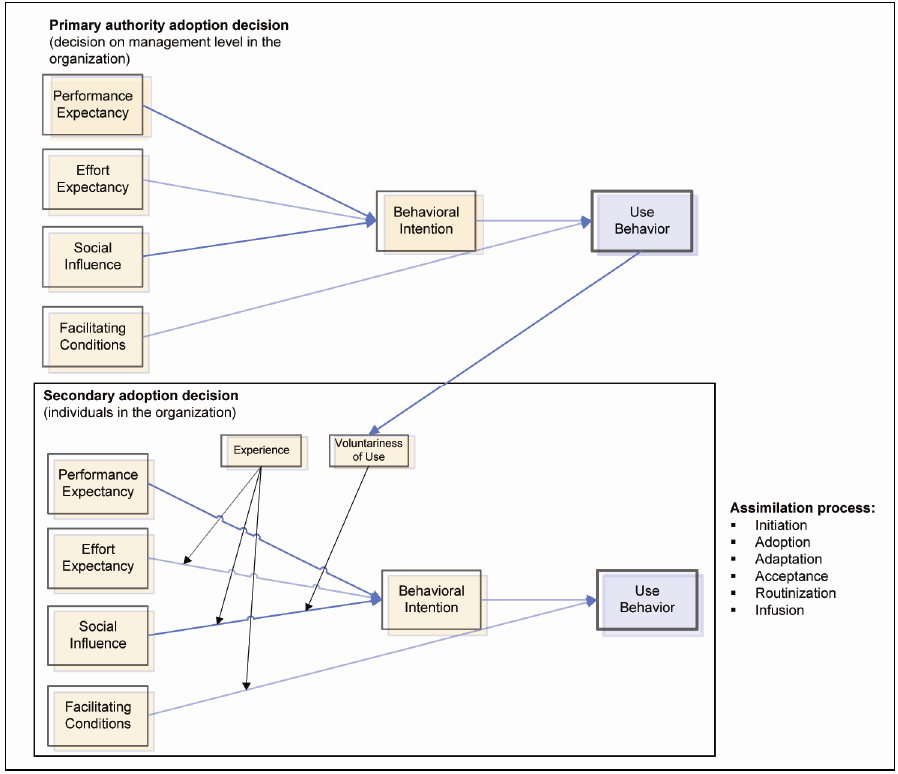
Fig. 7. Proposal for a combination of UTAUT (Venkatesh et al. 2003), Gallivan’s two-step mo- del (Gallivan 2001) and the stage model for implementation and assimilation (Samuelson